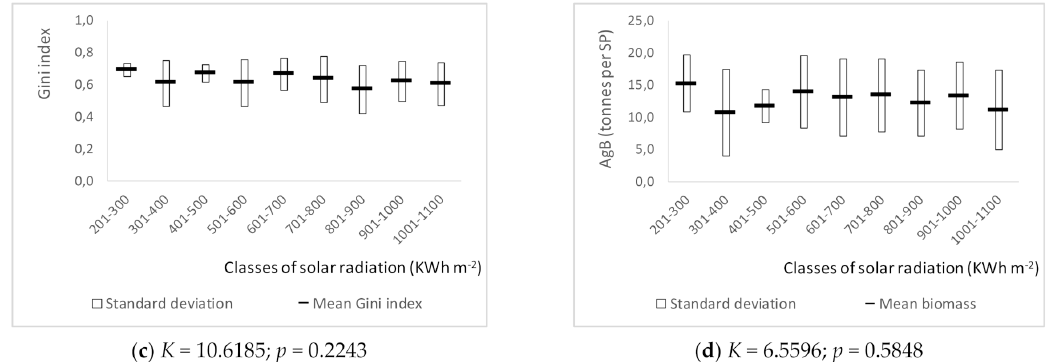
Figure 4. Relationship between solar radiation in growing season and tree species number ( a ), tree species diversity ( b ), tree size heterogeneity ( c ), and aboveground biomass of living trees ( d ). K represents the Kruskal–Wallis constant, while p indicates the significance level.